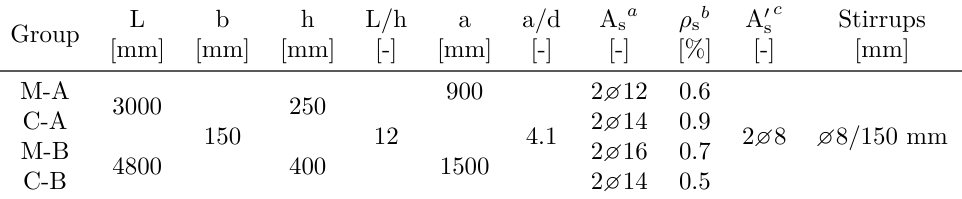
Table 1. Geometrical properties and internal steel reinforcement of tested